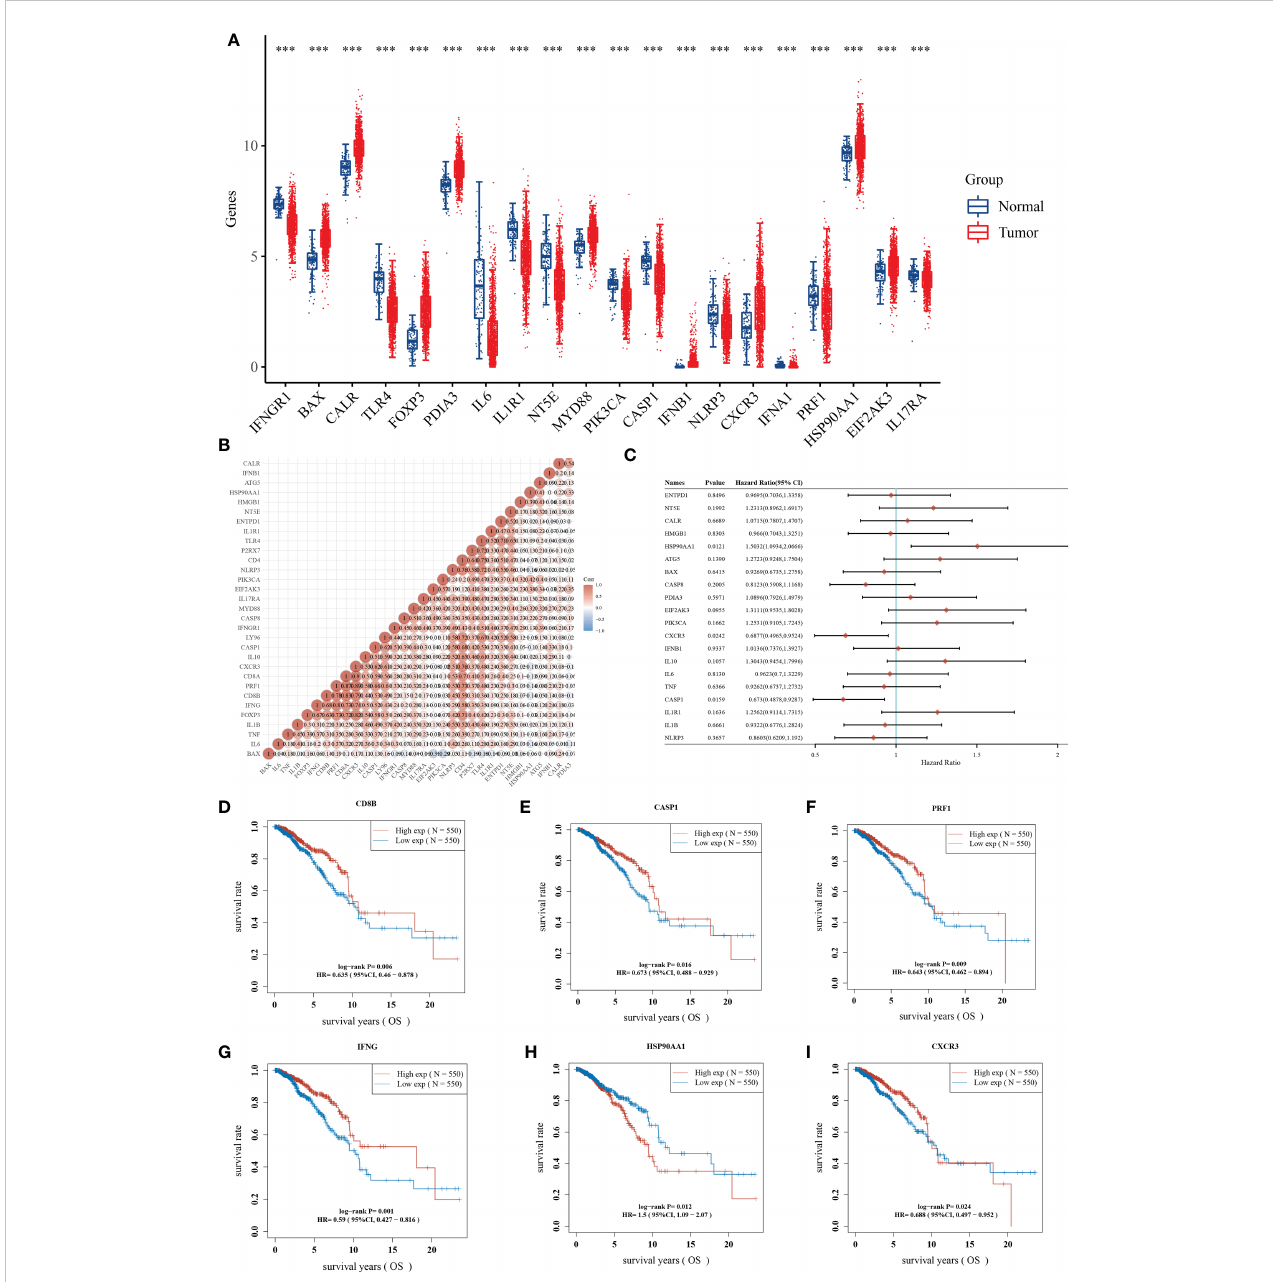
FIGURE 2 Identi fi cation of prognostic ICDRGs. (A) The expression pro fi le of ICDRGs between the normal and tumor groups. (B) Correlation analysis of the relationship among ICDRGs. (C) Univariate Cox regression analysis showed the correlation between ICDRGs and BRCA prognosis. (D-I) Survival analysis of several ICDRGs in BRCA. **P<0.01; ***P<0.005;